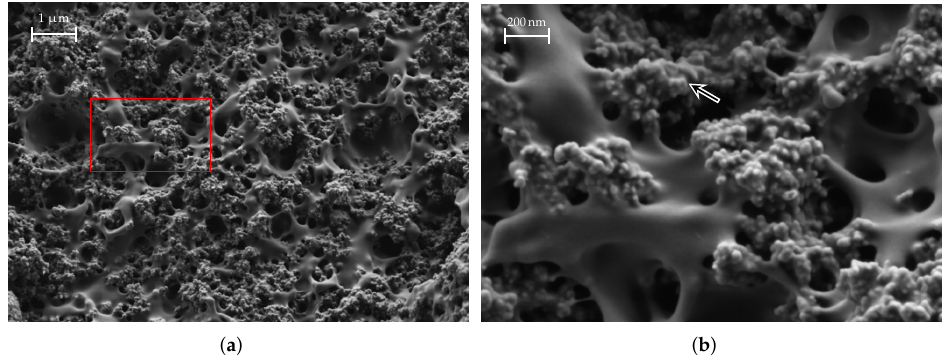
Figure 15. SEM images of a CDP filament material sample. The red-marked area is shown enlarged on the right. The arrow marks a chunk of filler material, which is carbon black. The smooth structure is the PLA matrix. ( a ) CDP, medium magnification; ( b ) CDP, large magnification.